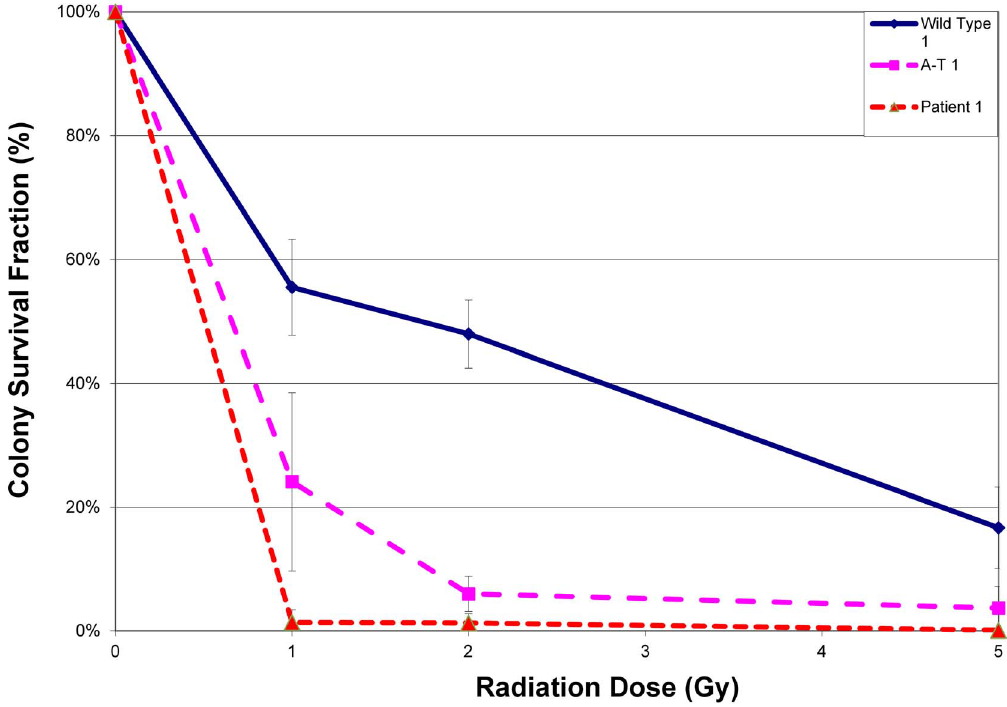
Figure 7. Colony survival assay demonstrates cellular radiosensitivity in Patient 1. Fibroblasts from Patient 1 were highly sensitive to increasing doses of ionizing radiation. Experiments were performed in triplicate with the average of three experiments shown. WT = wild type; A-T = ataxia-telangiectasia control.